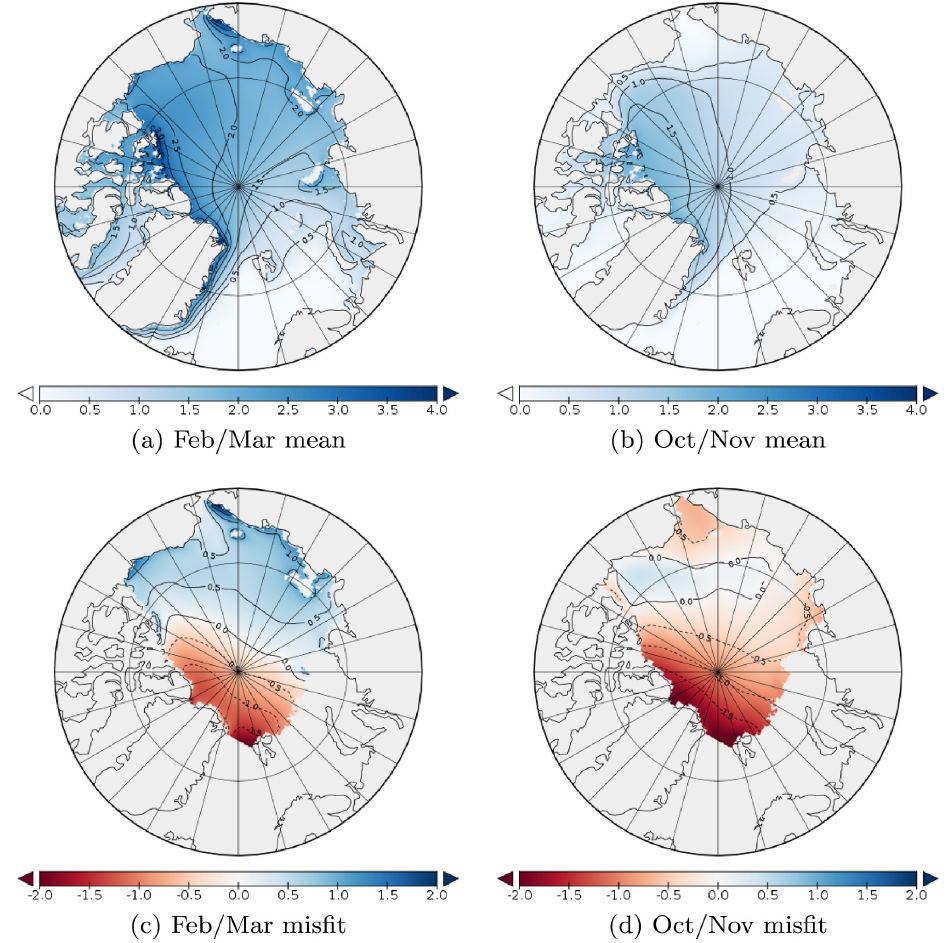
Figure 7. The long-term mean (2000 to 2012) of the simulated sea ice thickness (m) for the 2-month periods February–March and October– November (panel a and b ) and the misfit (model – observations) to the ITRP (panel c and d ). In panels (c) and (d) , shades of red indicate underestimation and shades of blue indicate overestimation of sea ice thickness in the